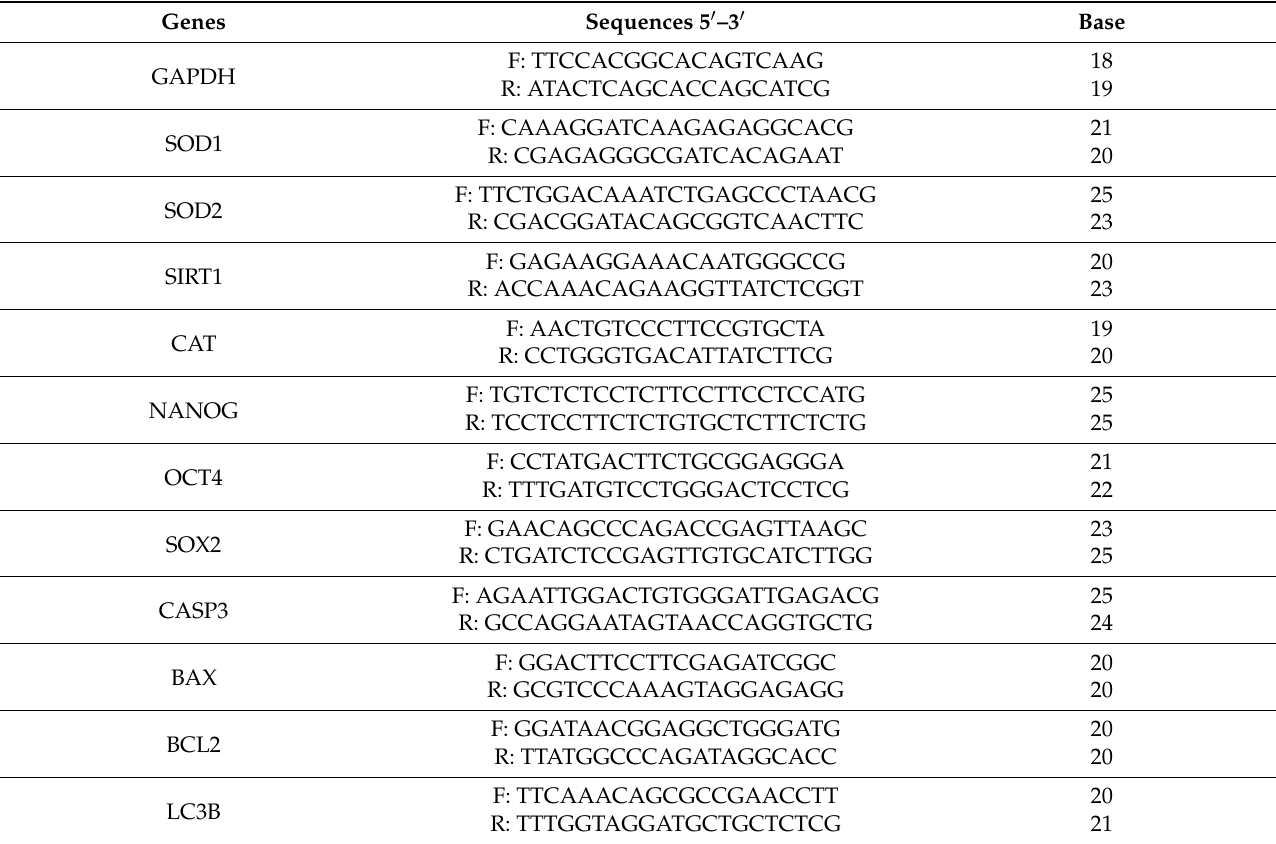
Table 1. Primer sequences used for